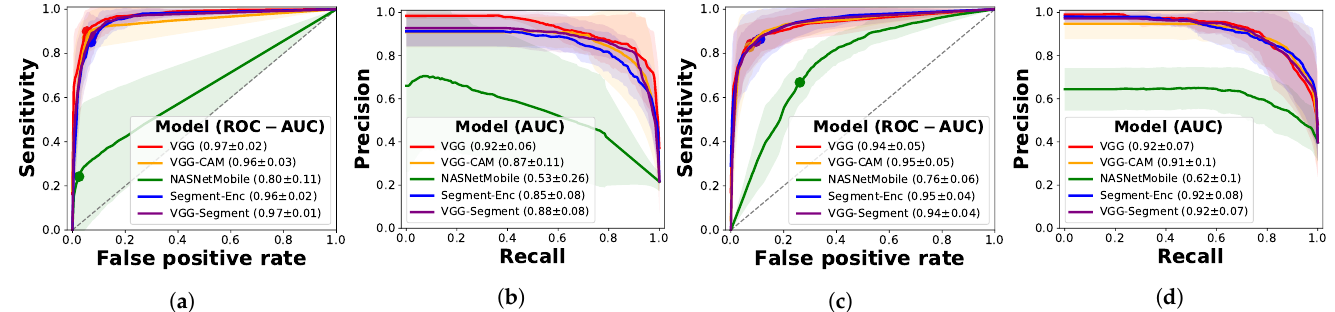
Figure A2. Binary classification results. All models achieve good precision and recall in pneumonia detection, but lower scores and higher variances are observed for data of healthy patients. ( a ) ROC-curve (Pneumonia), ( b ) Precision-recall (Pneumonia), ( c ) ROC-curve (Healthy), ( d ) Precision-recall (Healthy).